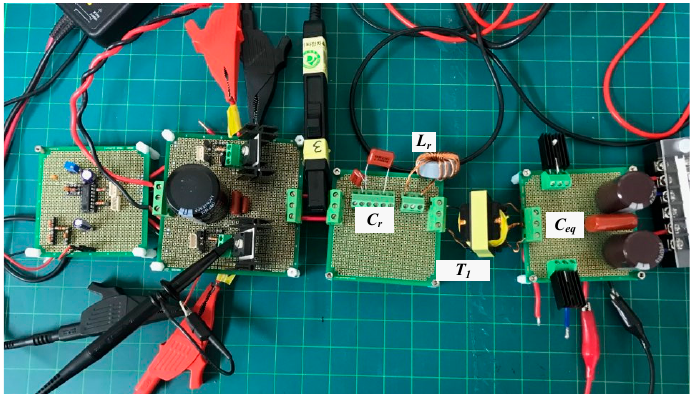
Figure 5. Experimental setup.